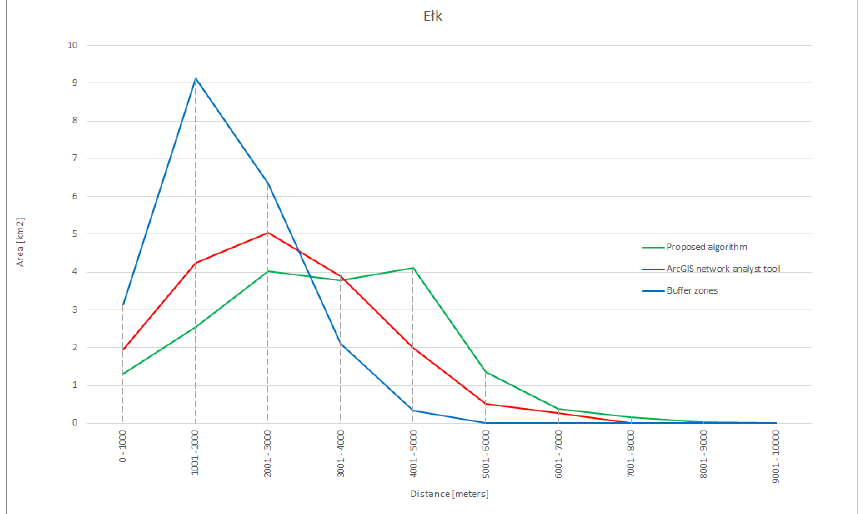
Figure 14. The results generated by different methods for identifying service areas in the city of